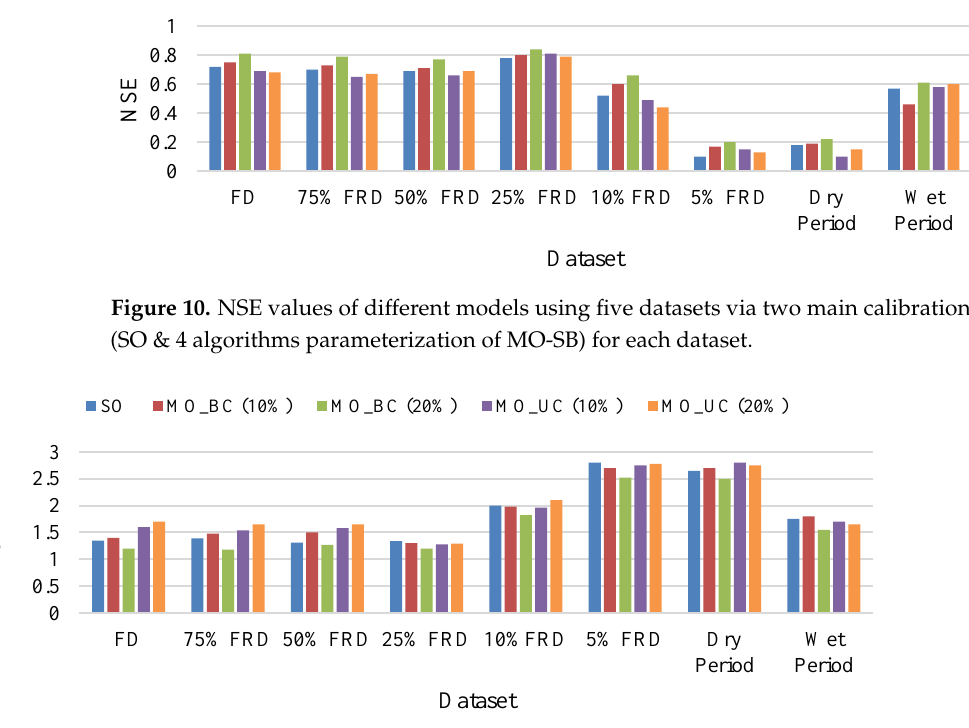
Figure 11. RMSE values of different models using five datasets via two main calibration approaches (SO & 4 algorithms parameterization of MO-SB) for each dataset.